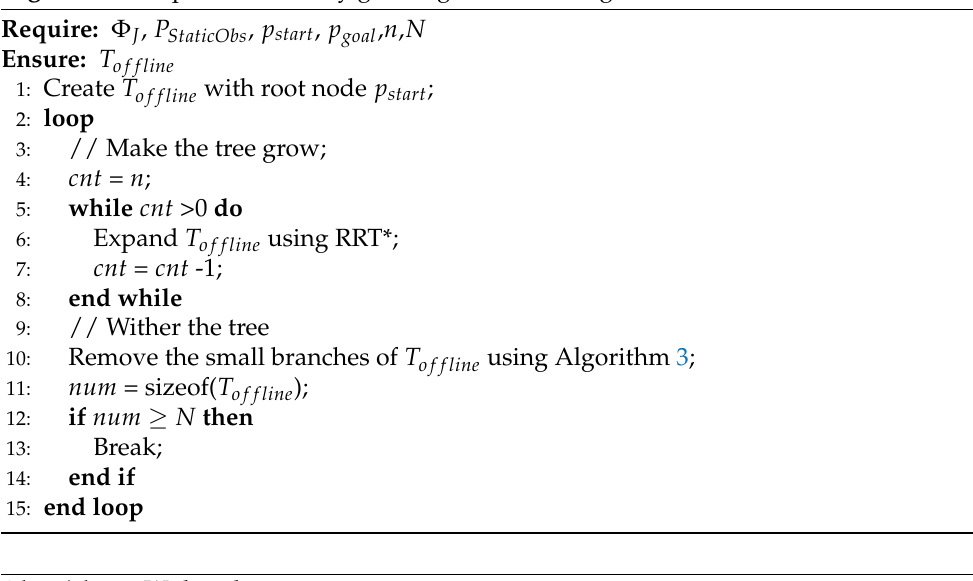
Algorithm 1 Expand the tree by growing and